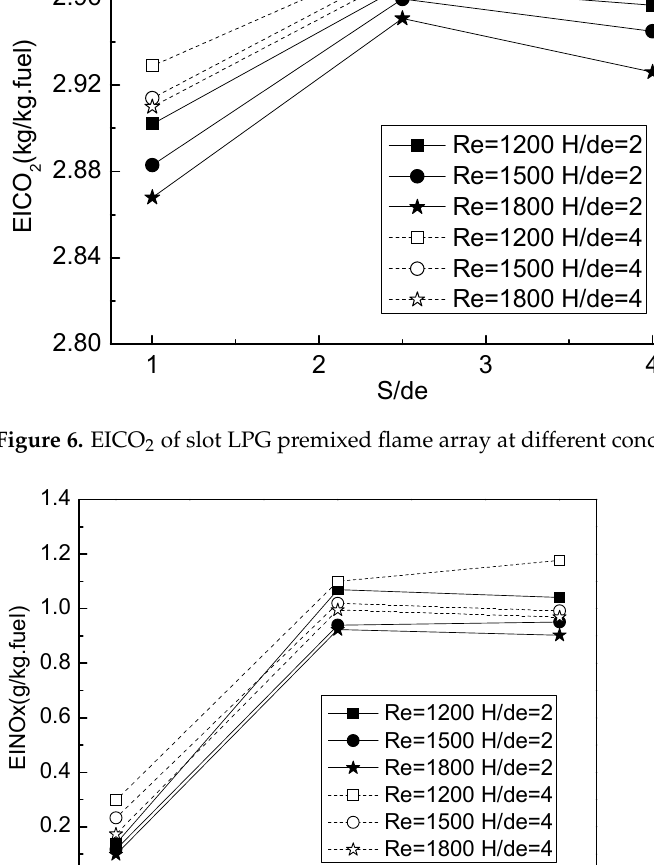
Figure 6. EICO 2 of slot LPG premixed flame array at different conditions.